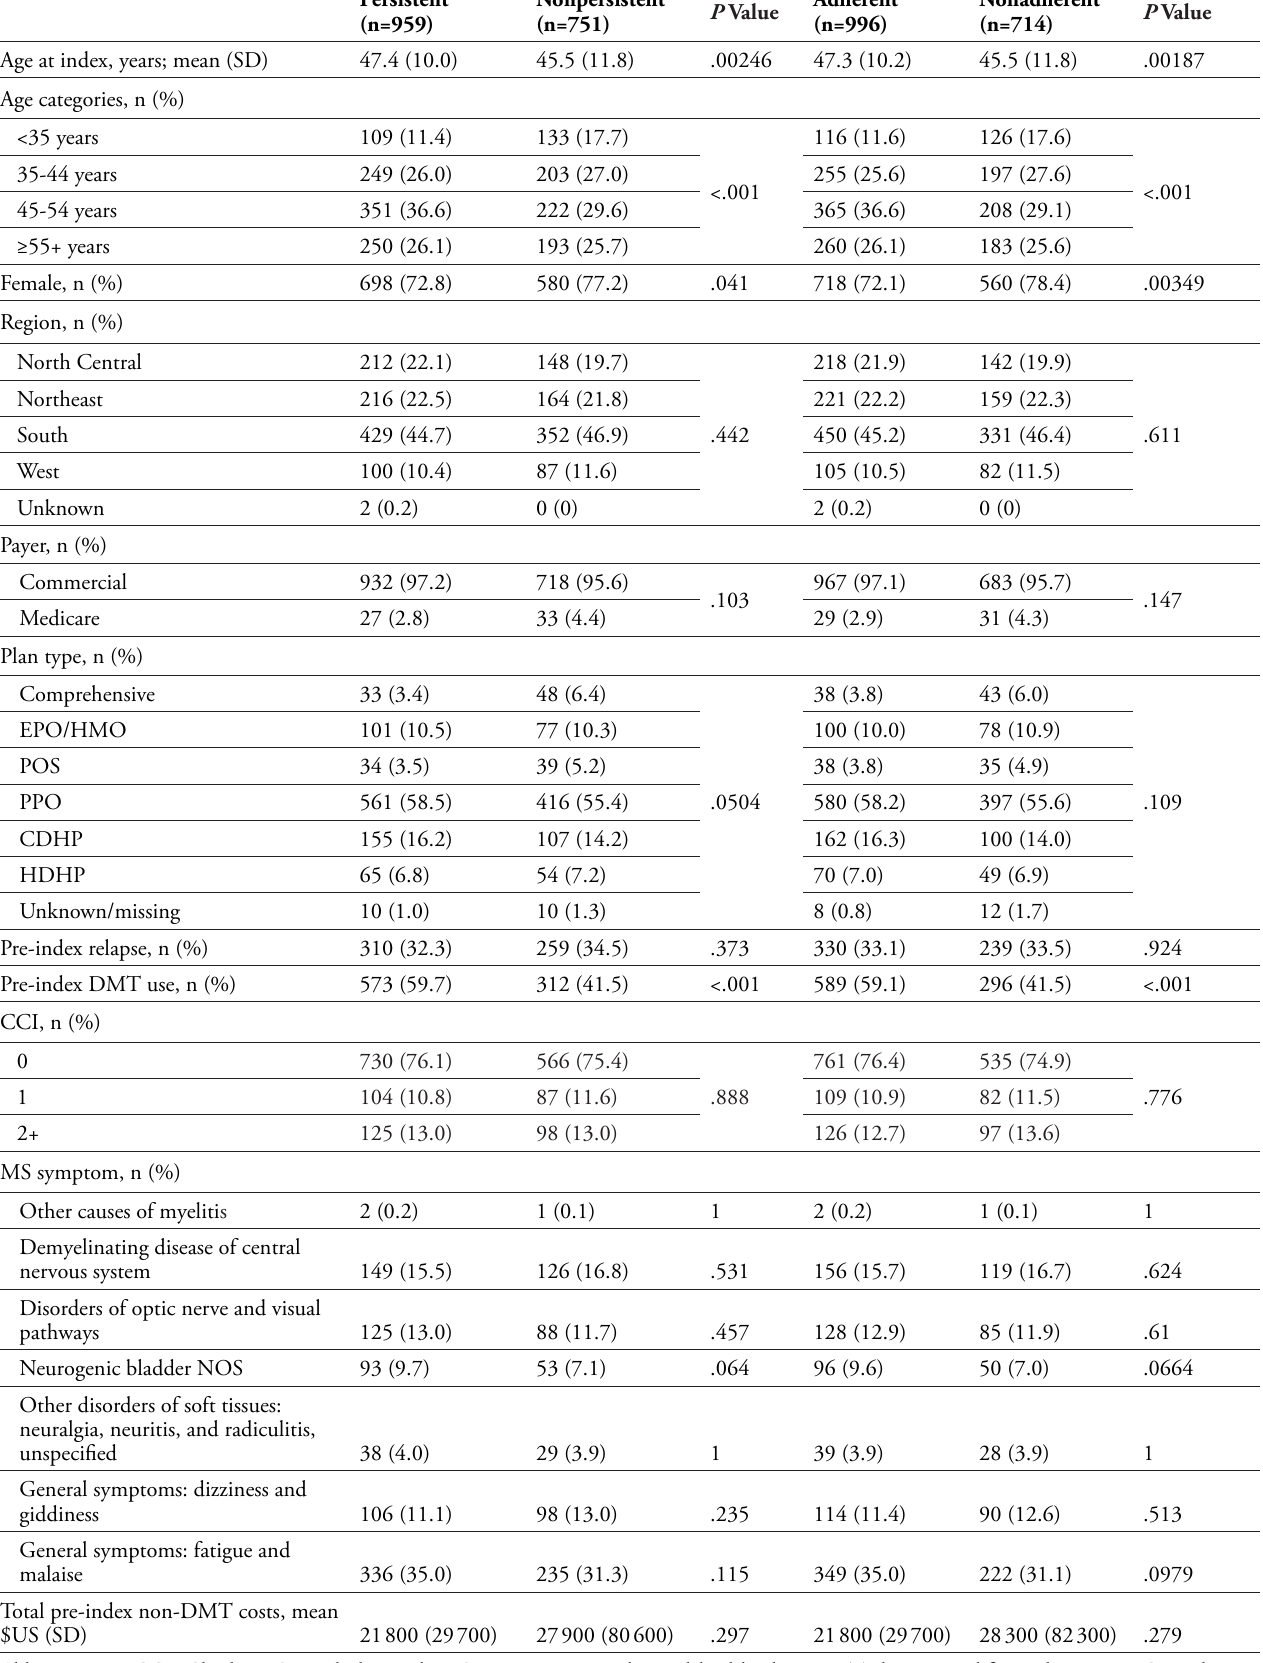
Table 1. Patient Demographic and Clinical Characteristics